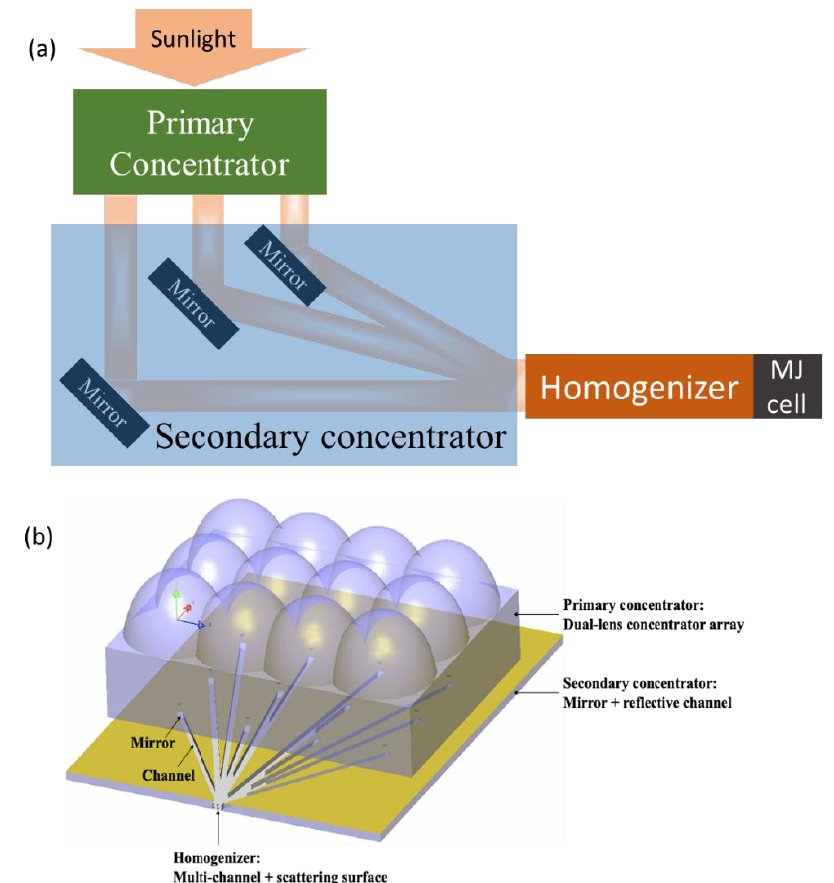
Figure 1. ( a ) Scheme of the proposed CPV system composed of a primary dual-lens concentrator, a secondary concentrator, and a homogenizer with targeting high concentration ratio value. ( b ) 3D illustration of our proposed design by LightTools software (Version 9.0, Synopsys, Inc., Mountain View, CA, USA).